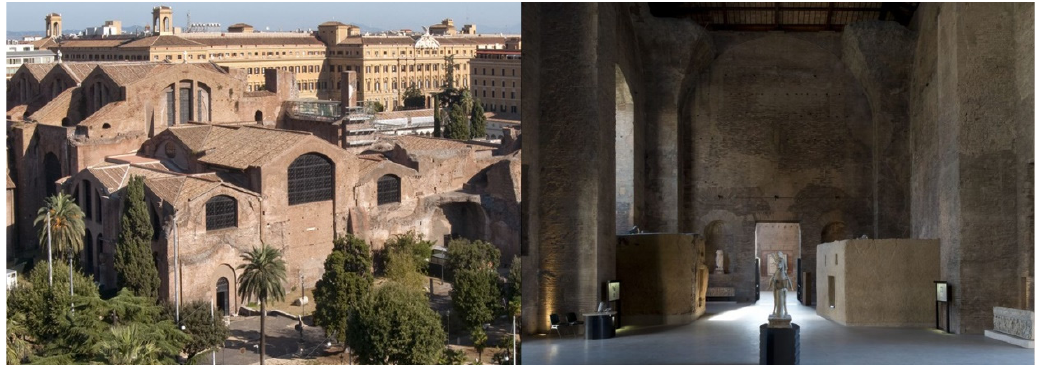
Figure 2. National Roman Museum. Baths of Diocletian Source: Museo Nazionale Romano [74].